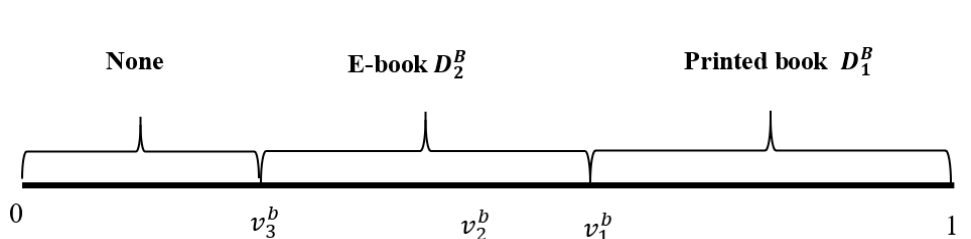
(cid:3017) (cid:3118) θ . (cid:3087)